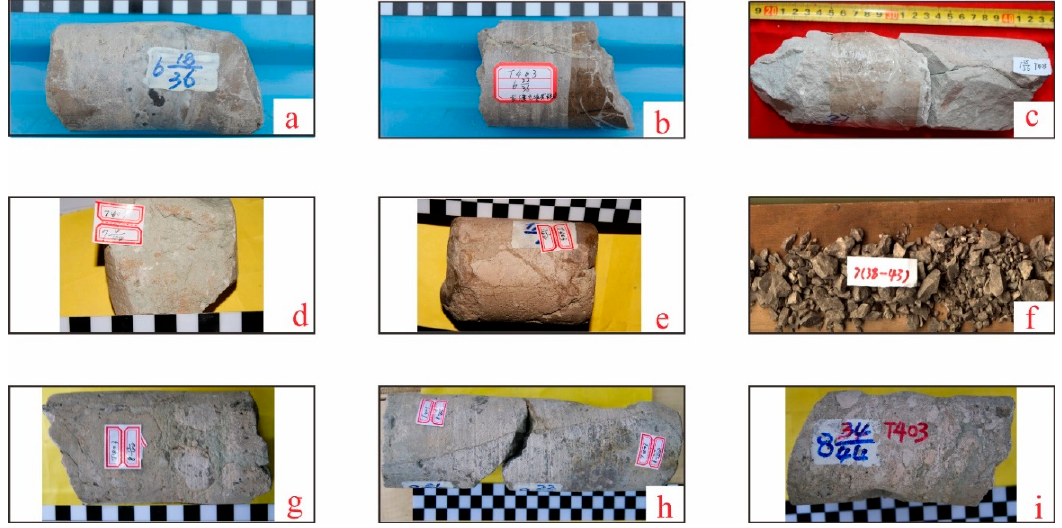
Figure 3. Core photos from well T403, illustrating the cave fillings and fractures. ( a ) The tip hole is filled with chemical filling, ( b ) fractures filled with gray–green debris filling, ( c ) light green fine debris filling, ( d ) thick debris filling, ( e ) sub-angular breccia, ( f ) angular collapsed breccia, ( g ) secondary rounded breccia with ash green fine debris filling, ( h ) coarse debris filling with breccia, ( i ) secondary round transport breccia.